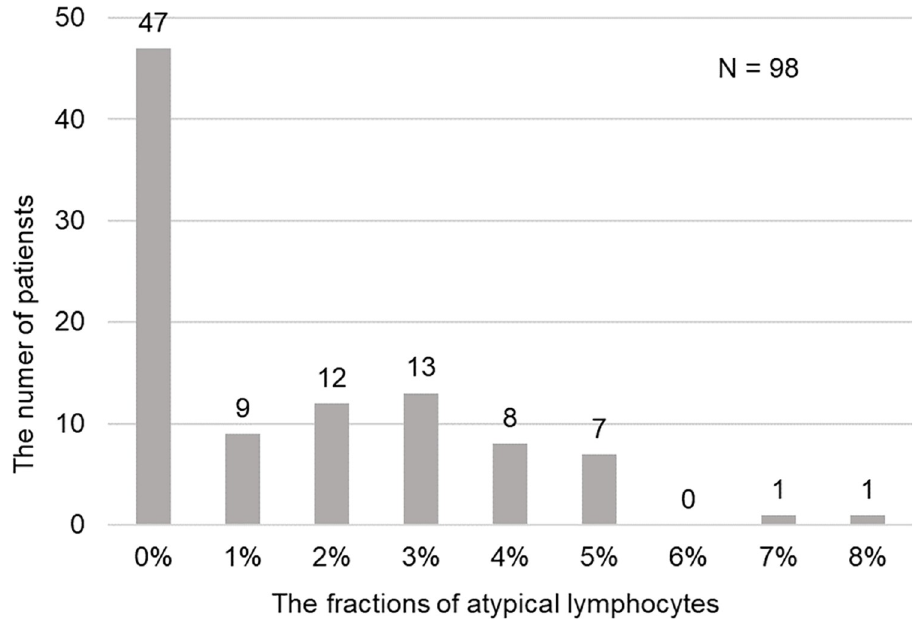
Fig 2. Distribution of the fractions of atypical lymphocytes. The number of patients in each fraction of atypical lymphocytes is shown. Each patient was classified according to their peak value. Numbers above bars indicate the actual counts of each fraction.